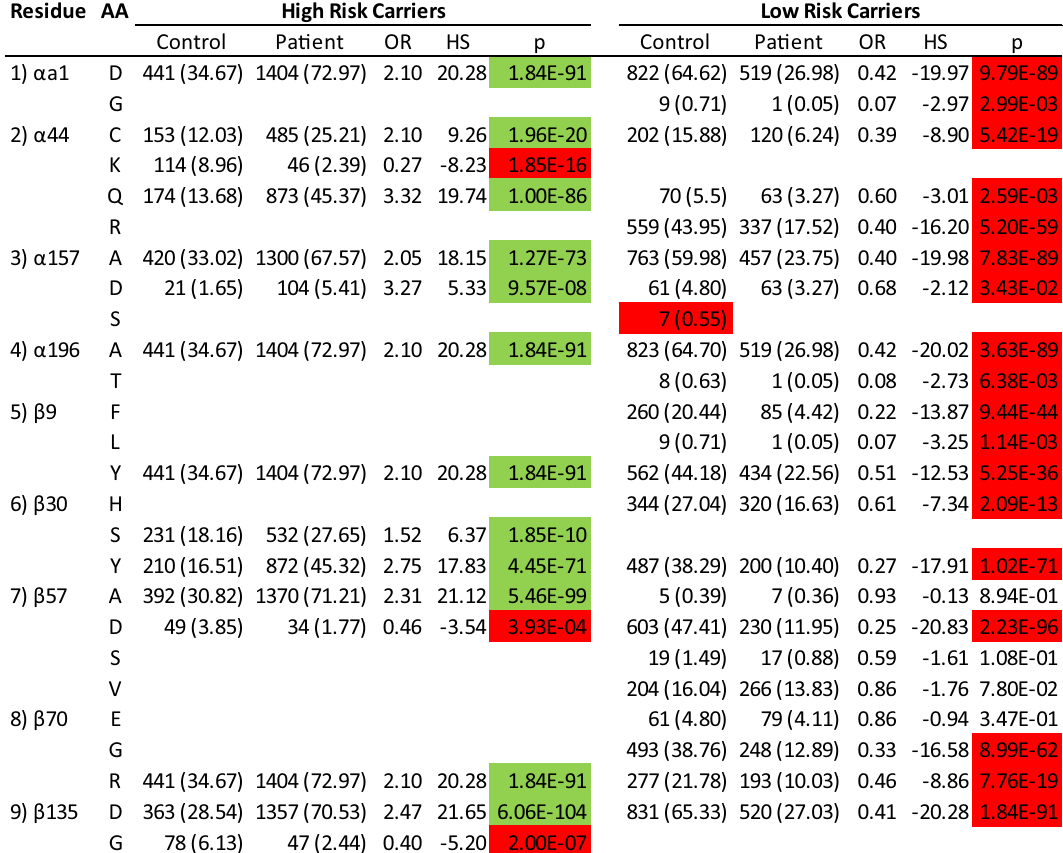
absent. The association with αa1D was significantly different between low and high-risk subjects (exact Fisher’s